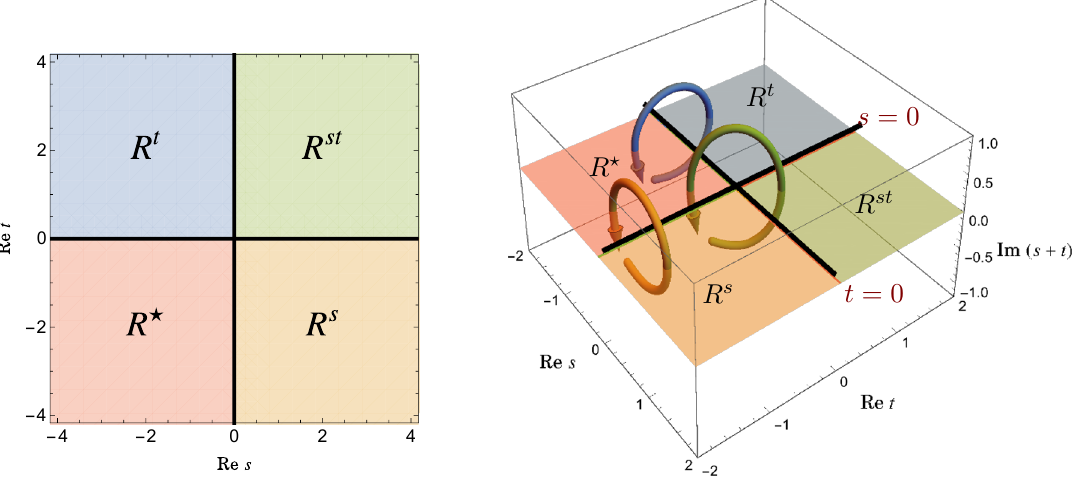
Figure 4 . The function ln( − s ) ln( − t ) has branch hypersurfaces at s = 0 and t = 0 , shown in black. The Euclidean region R ? corresponds to s < 0 and t < 0 . We can compute discontinuities in s and t of M by rotating around the branch points as indicated by the curves on the right. These curves pass out of the real s, t